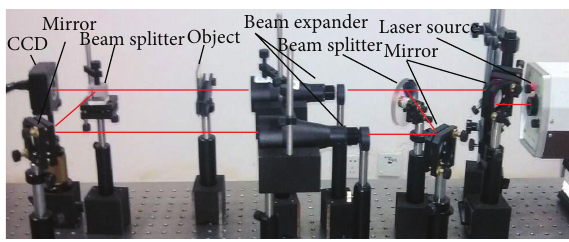
Figure 4: Experimental setup for recording test target holograms.